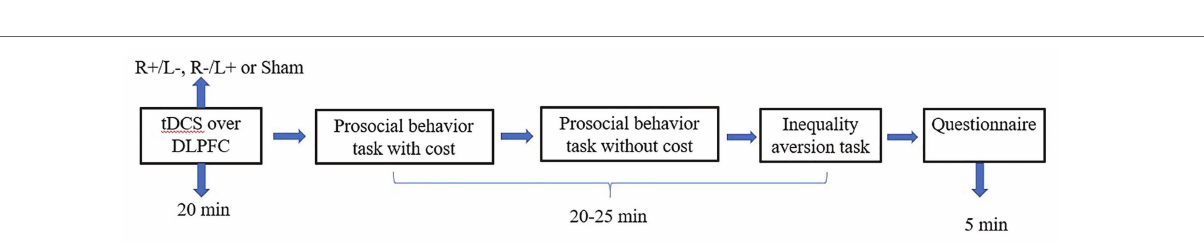
FIGURE 3 | Schematic representation of the experimental design in experiment 1. After 20 min of stimulation, the participant was asked to complete the costly antisocial behavior task, the antisocial behavior without cost task, and the inequality aversion task.